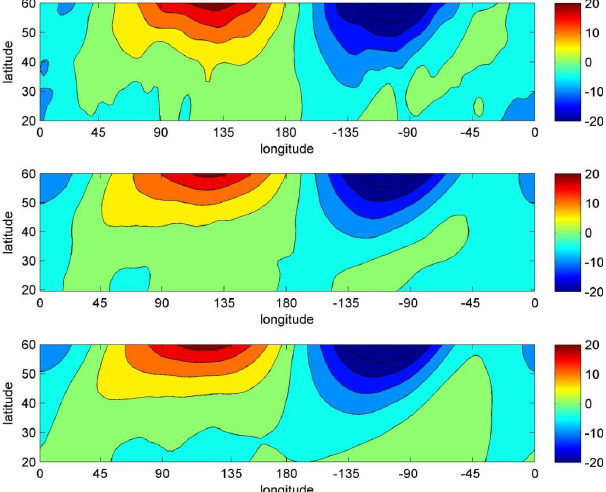
Figure 2. The same as Fig. 1 but for